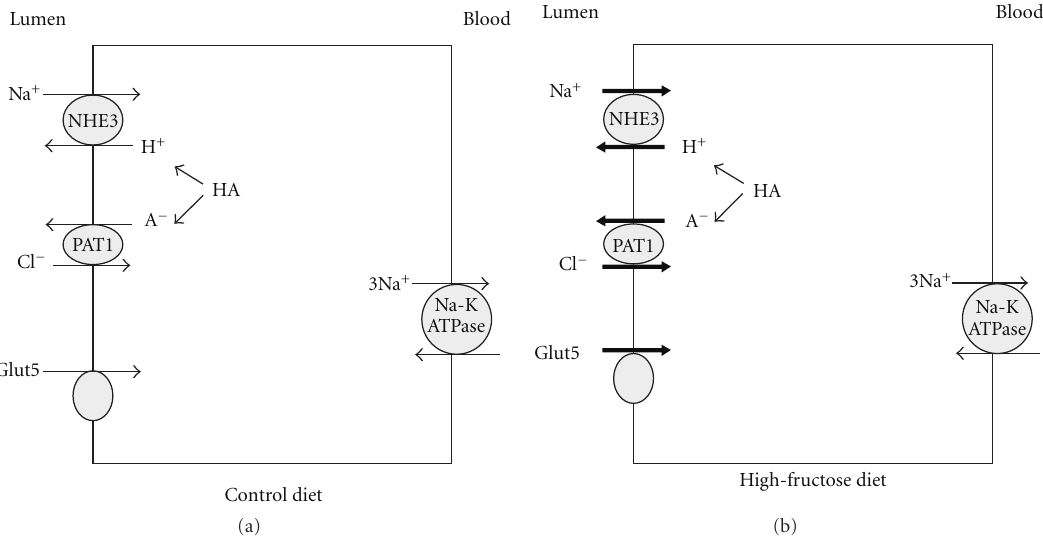
Figure 4: E ff ect of increased dietary fructose on Glut5 and salt-absorbing transporters in kidney proximal tubule. Increased dietary fructose intake enhances the expression of Glut5 and increases the absorption of salt via NHE3 and PAT1 in the kidney proximal tubule (see [13] and personal